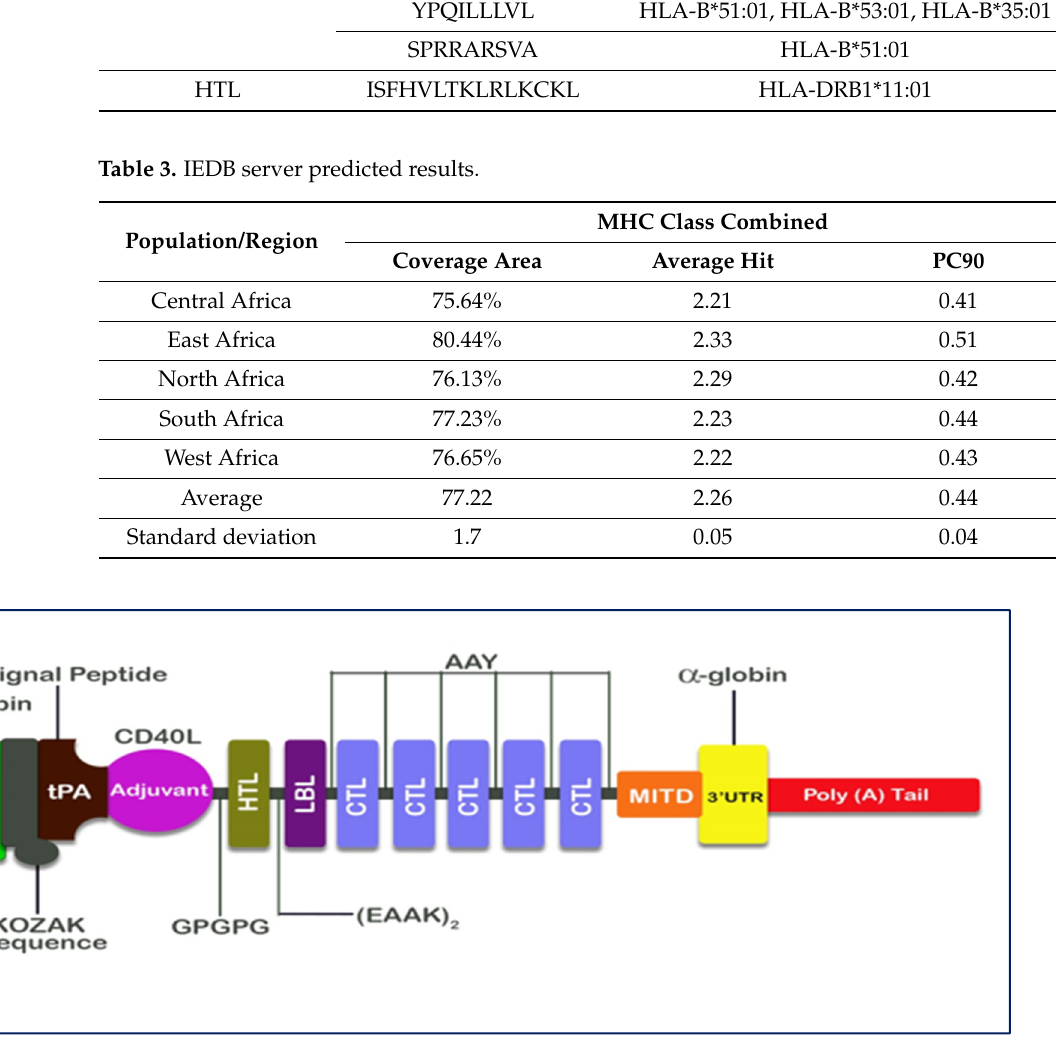
Figure 3. Scheme of the formulation of the mRNA vaccine against